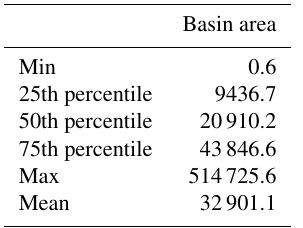
Table A2. Descriptive statistics, expressed in square kilometres, of the 2776 river basins included in the analysis.